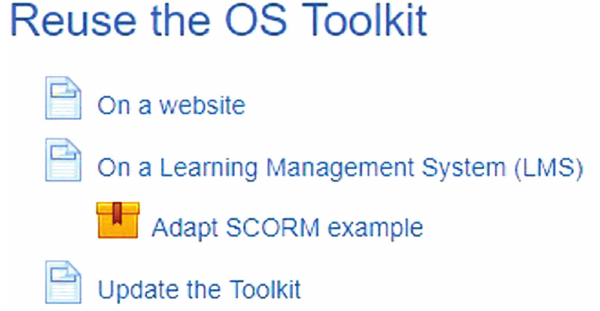
Fig. 6: Content of the course “Reuse the OS